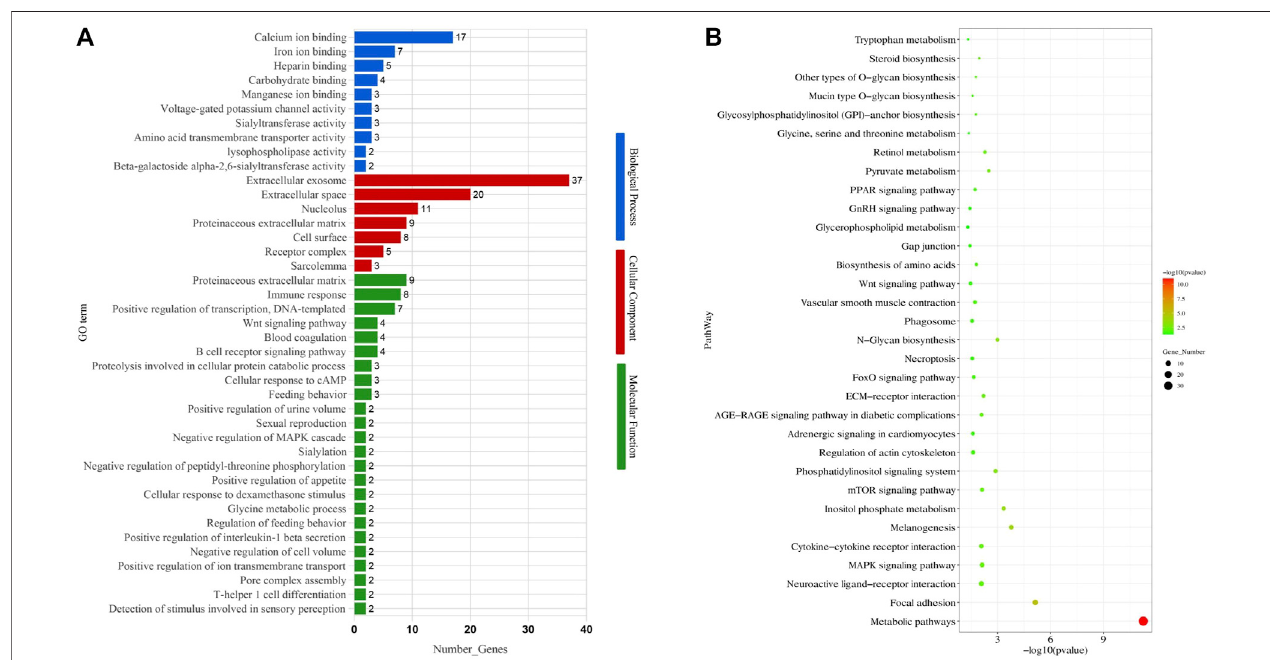
FIGURE 2 | Gene Ontology (GO) terms and KEGG pathways enriched of differentially expressed genes. (A) GO terms. (B) KEGG pathways.